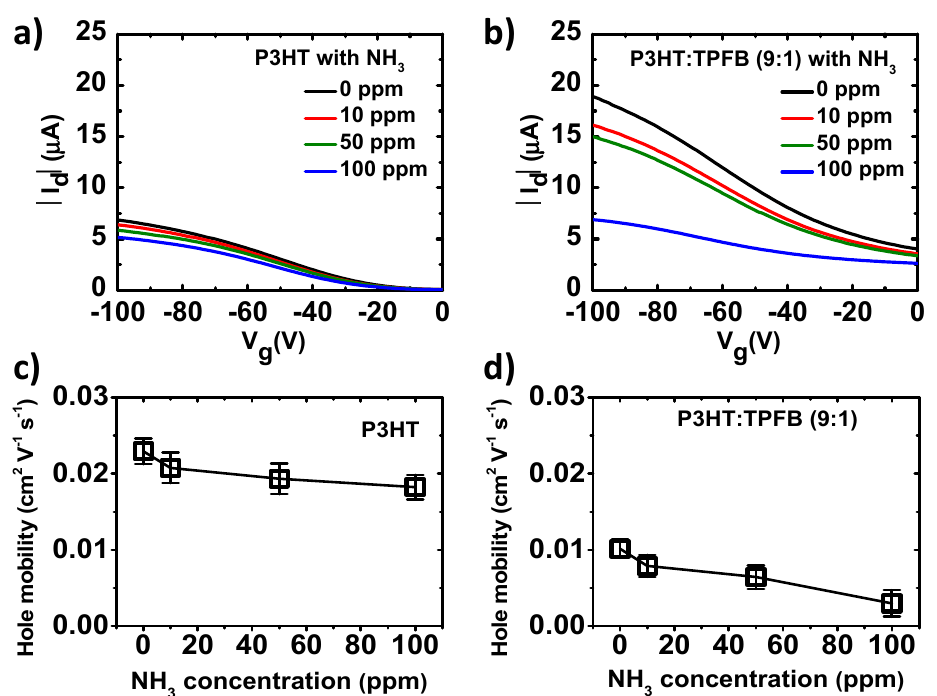
Figure 3. Current–voltage curves and electrical parameters of the P3HT and P3HT:TPFB devices exposed to different NH 3 concentrations: ( a ) Transfer curves of the OFET with the pristine P3HT with a thickness of 31.3 nm. ( b ) Transfer curves of the OFET with the P3HT:TPFB (9:1) film with a thickness of 30.9 nm. Field-effect mobilities of ( c ) pristine P3HT and ( d ) P3HT:TPFB (9:1) devices. V d was fixed at − 100 V.